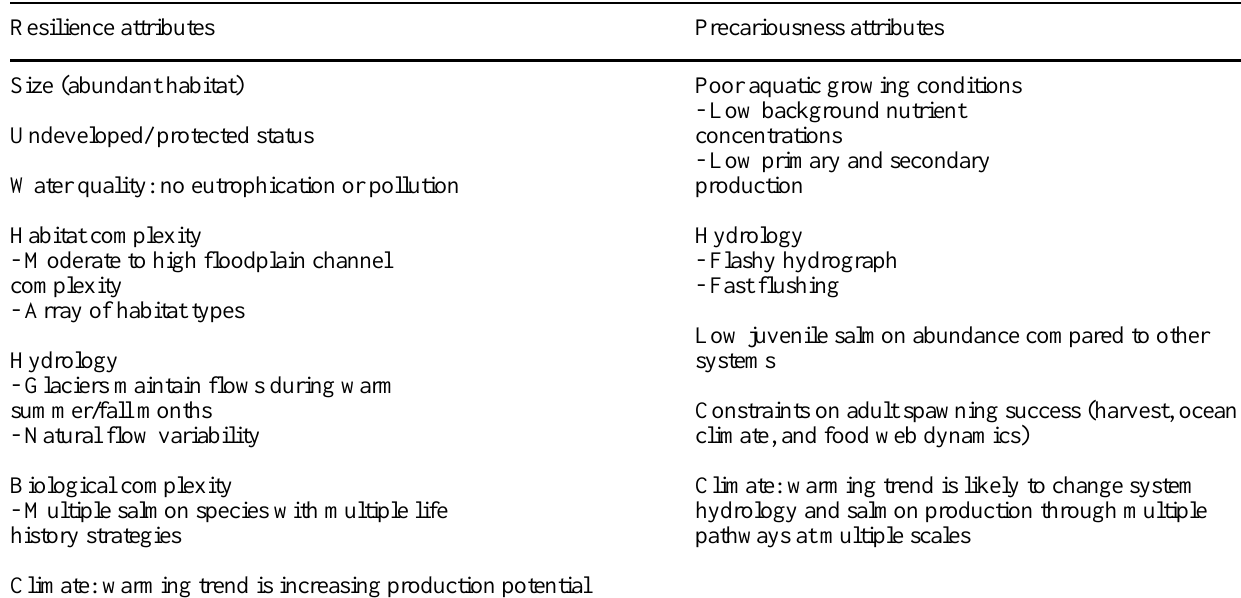
Table 4 . Summary of attributes likely to foster resilience and precariousness in Kitlope River salmon